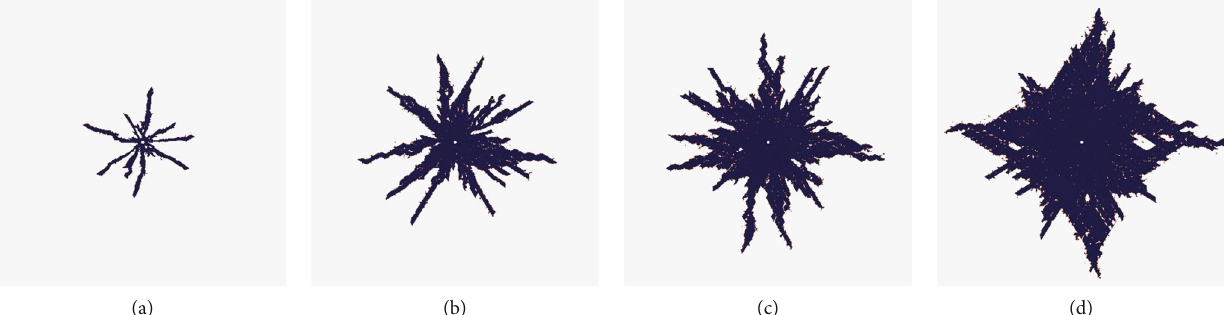
Figure 5: Distribution of the damaged area under di ff erent water injection pressures at 5min. (a) p 5MPa , and (d) p